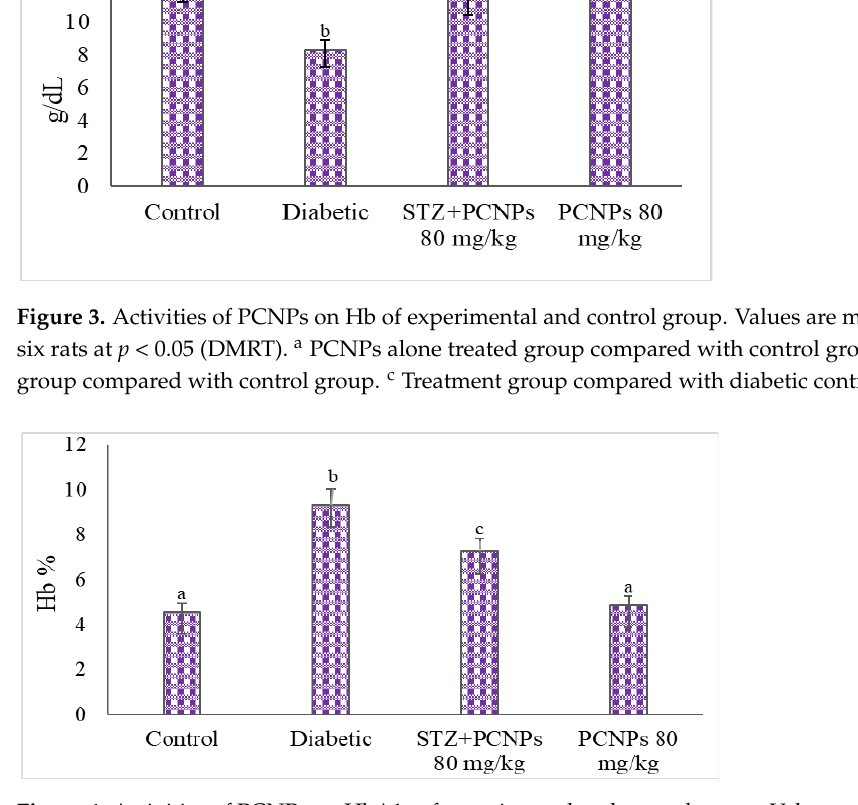
Figure 6. Activities of PCNPs on creatinine of control and experimental group. Values are mean ± SD for six rats at p < 0.05 (DMRT). a PCNPs alone treated group compared with control group. b Diabetic group compared with control group. c Treatment group compared with diabetic control. 3.6. Urinary NAG, β-Glucuronidase and Microalbumin Level Figure 7 shows the effects of PCNPs on the NAG, β-glucuronidase and albumin levels. In contrast to the nephropathic control group, the DN rats treated with PCNPs had their NAG, β-glucuronidase and albumin levels return to near normal. The rats admin- istered PCNPs alone showed no significant change in urinary markers compared with normal rats. Figure 7. Activities of PCNPs on urinary NAG, β-Glucoronidase and microalbumin of control and experimental group. Values are means ± SD for six rats at p < 0.05 (DMRT). a PCNPs alone treated